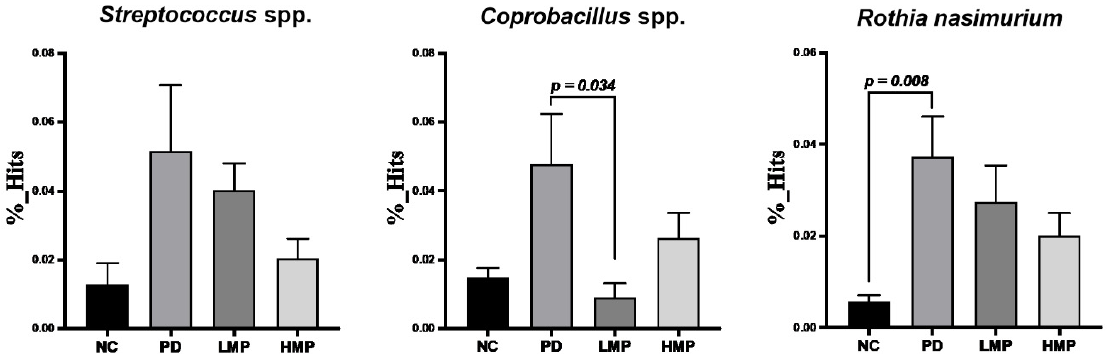
Figure 8. Analysis of the abundance of specific bacteria at the genus level after 8 weeks of supple- mentation in the low-dose mangosteen pericarp (LMP) and high-dose mangosteen pericarp (HMP). Results are average ± SEM for n = 5 rats/group and were analyzed using the unpaired t -test or Mann– Whitney test.